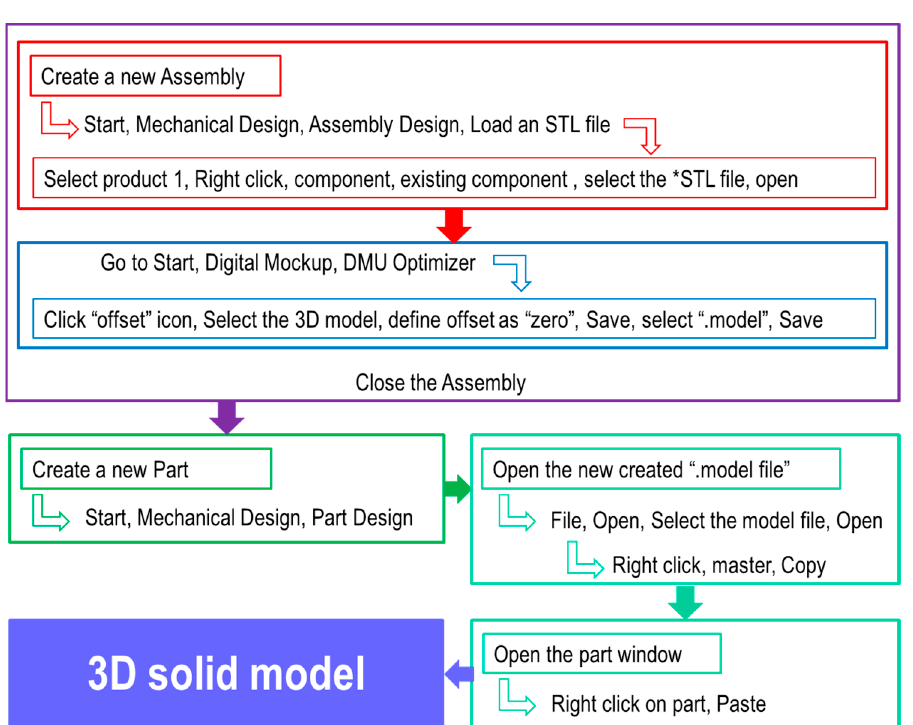
Figure 2. Steps for converting the STL files into 3D solid models using CATIA.